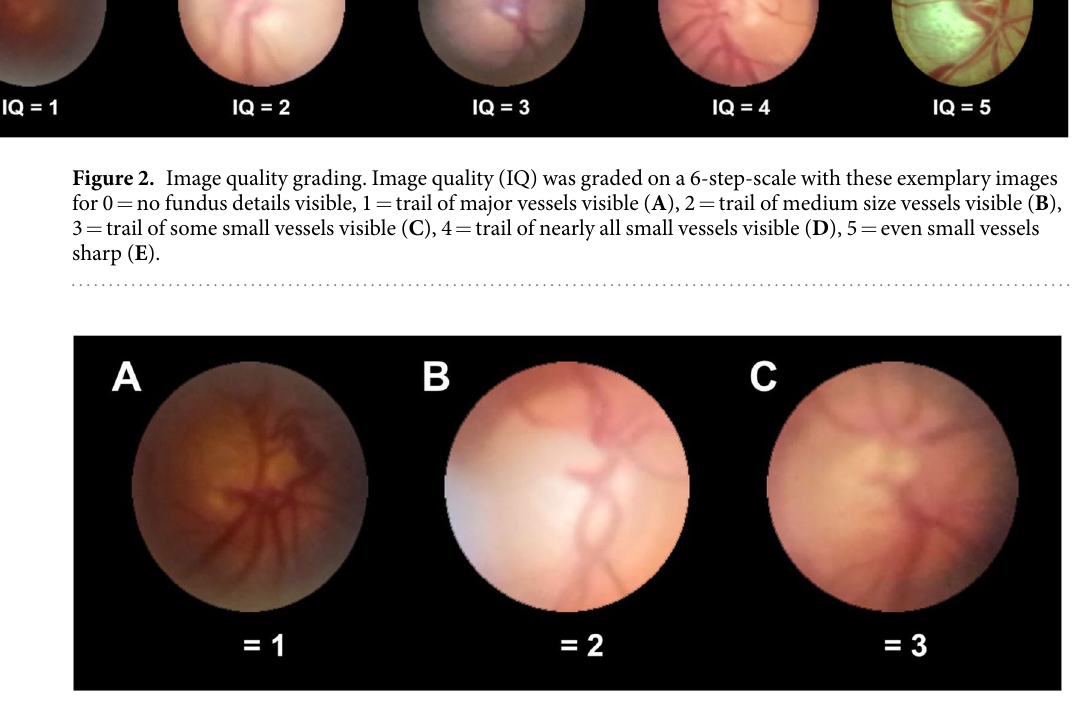
Figure 3. Optic disc rim visualization. Degree of optic disc rim visualization was graded on a 3-step-scale with these exemplary images for 1 = less than ¾ of the optic disc rim identifiable ( A ), 2 = at least ¾ of the optic disc rim identifiable ( B , the lower left of the optic disc rim is overlaid by a reflex) and 3 = optic disc rim completely identifiable ( C ).